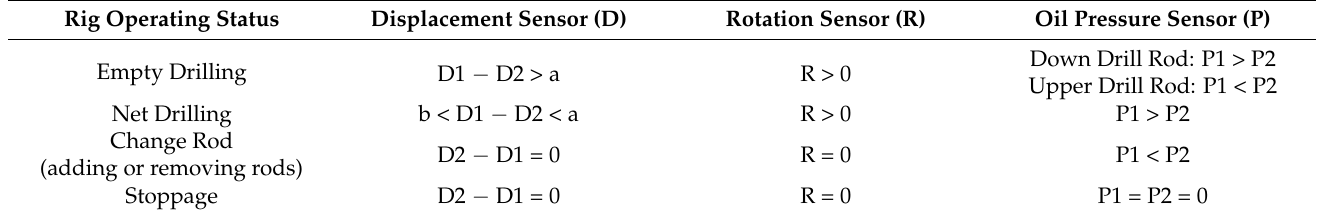
Table 2. Judgement conditions of the monitoring data for different drilling